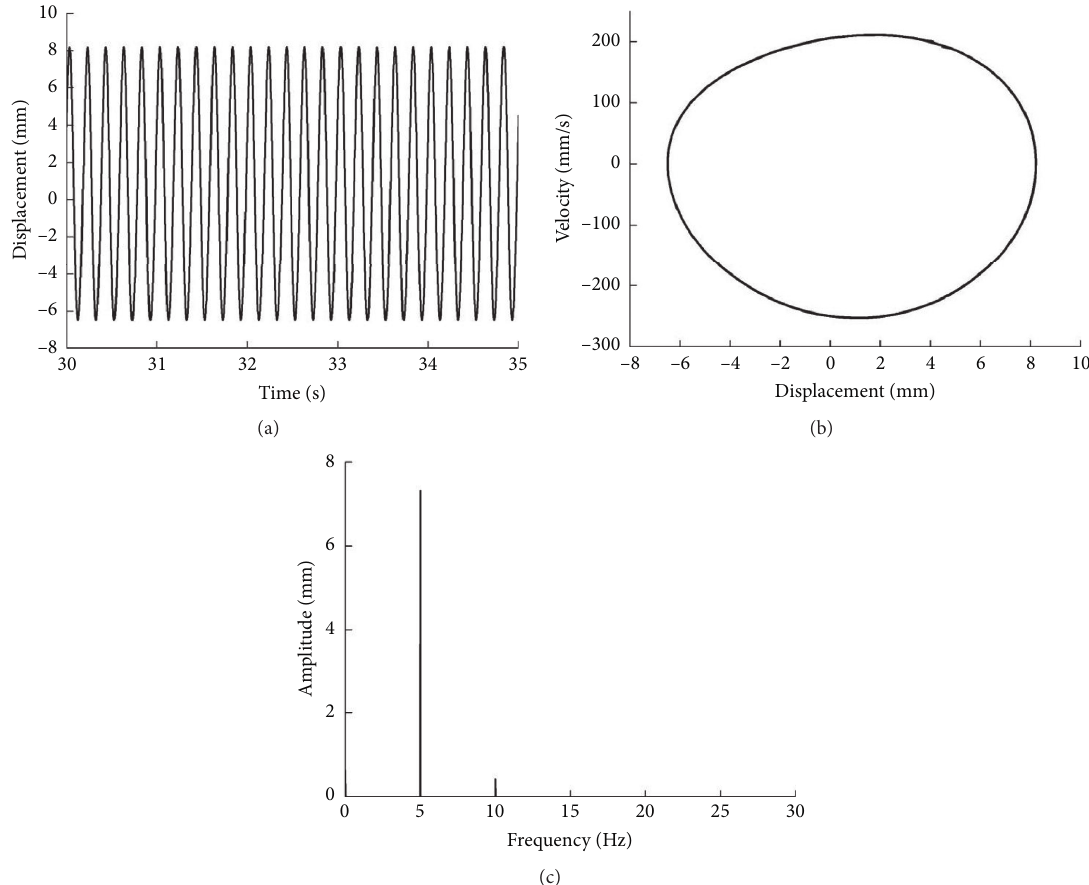
Figure 16: Period-1 motion of the structure C is obtained for the external excitation amplitude W � 2 . 5 V, the external excitation frequency Ω � 5Hz, and the magnetic distance 14mm: (a) waveform; (b) phase portrait; (c) amplitude